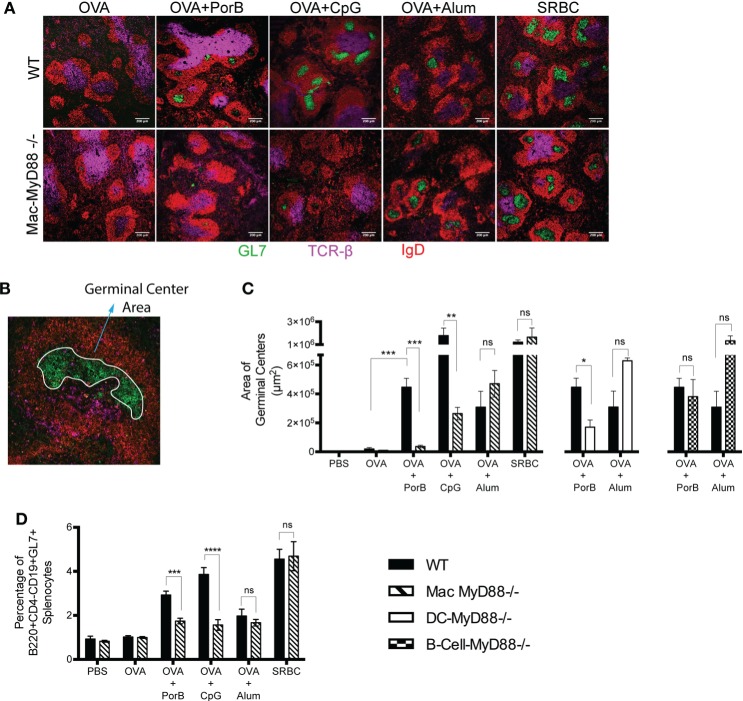
Formations of germinal centers (GCs) in the spleen are dependent on in vivo MyD88 signaling in macrophages upon immunization with toll-like receptor ligand-based adjuvants. (A) GC responses examined by confocal microscopy 7 days after the second immunization, 8 μm thick spleen sections were prepared and examined as described “Animals and Methods.” Sections were stained for IgD follicular B cell marker (red), GC B cell marker GL7 (green), and T cell marker TCR-β (cyan). (B) A spleen section with the GC area measured using the freehand selection tool in ImageJ, here the area of GC (green) is encircled in white. (C) Quantitation of GC areas by ImageJ. There were three mice per immunization group, 6 sections per spleen that are at least 40 μm apart and a total of 18 sections were examined per group. (D) Percentage of GC cells from spleen was measured by flow cytometry 7 days after the second immunization and gating for B220+CD4−CD19+GL7+GC cells. The results shown are representative of at least two experiments with a total of eight mice per immunization group for the flow cytometry analysis experiment. One-way ANOVA with Tukey’s test were used (ns, not significant P > 0.05, *P < 0.05, **P < 0.01, ***P < 0.001, and ****P < 0.0001).